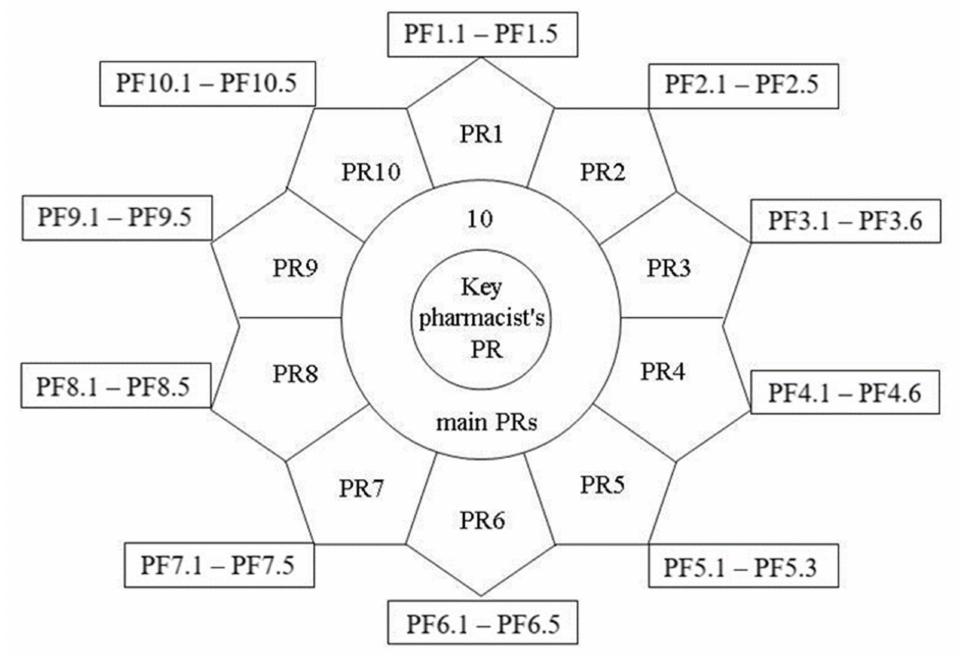
Figure 1. Decomposition of the main PR of the